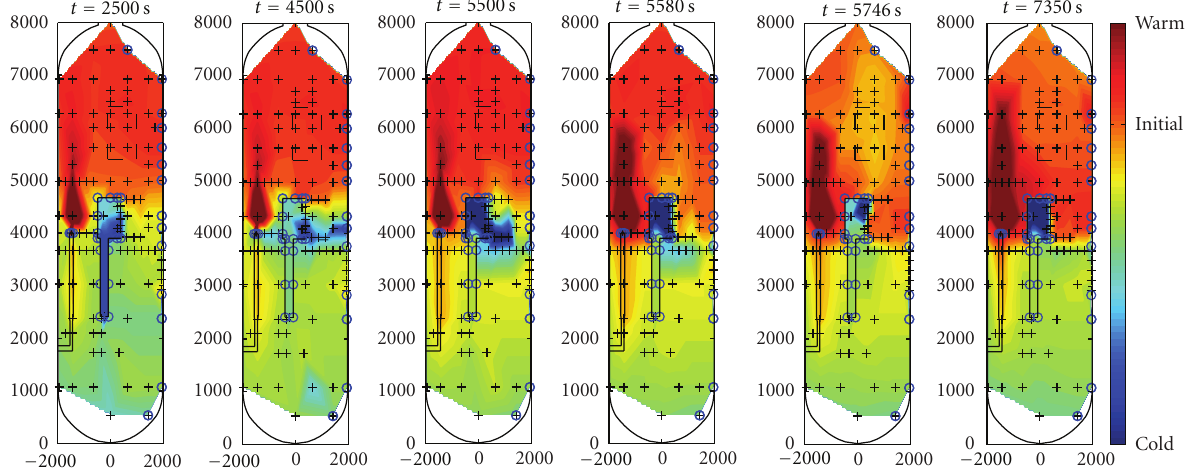
Figure 18: Temperature contour maps in Vessel 1 for experiment ST4 1 for di ff erent instances in time 0 < t < 7350 s.